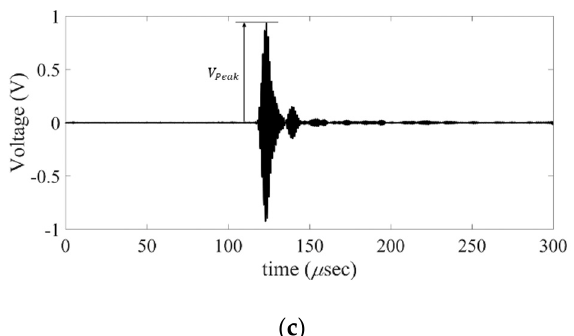
Figure 9. Experiment for the measurement of the 3D radiation beam profile of a leaky wave radiated from a SS304 plate with 1.5 mm thickness and 15 mm width in water, ( a ) experimental setup and ( b ) block diagram, and ( c ) A-scan signal of the leaky wave measured at the center of the radiation surface.